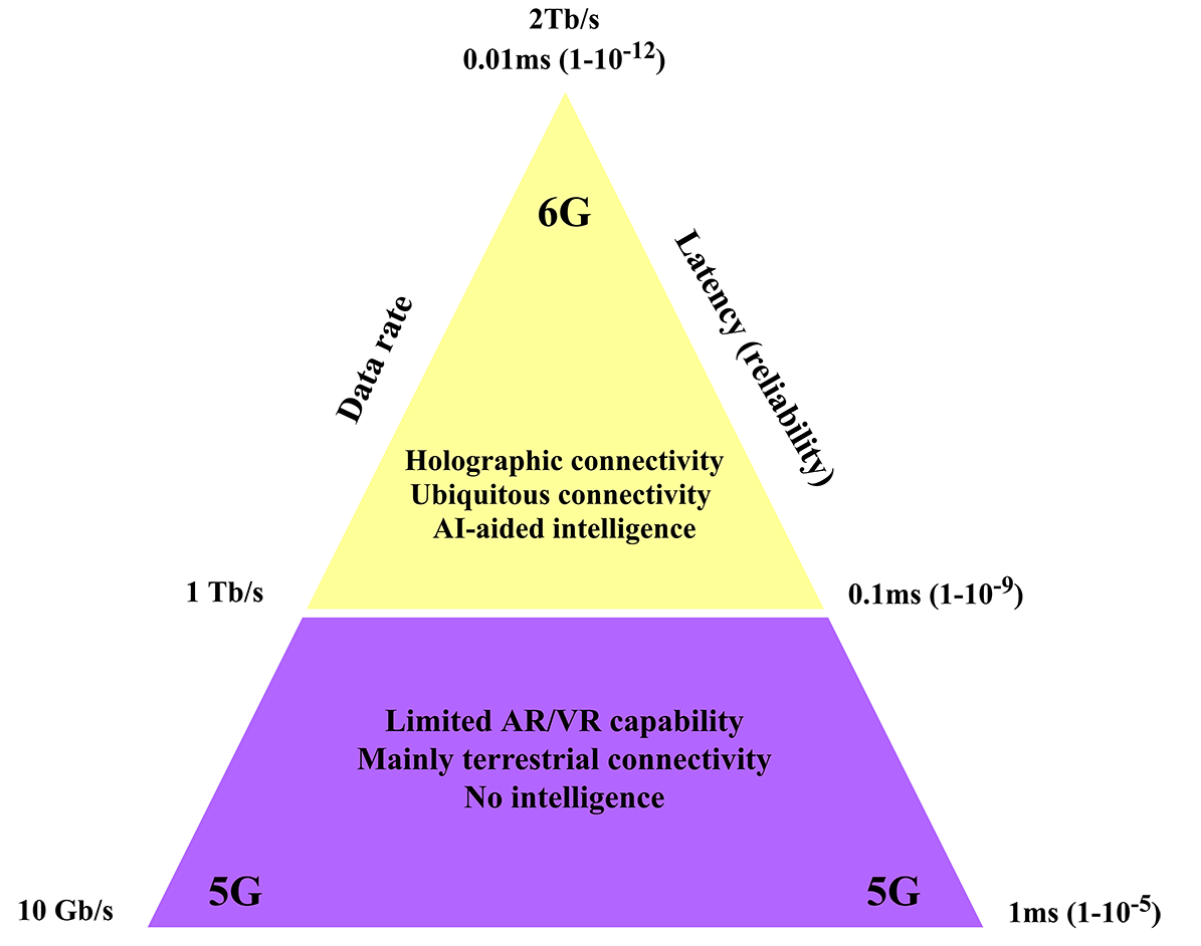
Figure 1. A schematic representation of the unique advantages of 6G compared to 5G technologies. AI: artificial intelligence, AR: augmented reality, VR: virtual